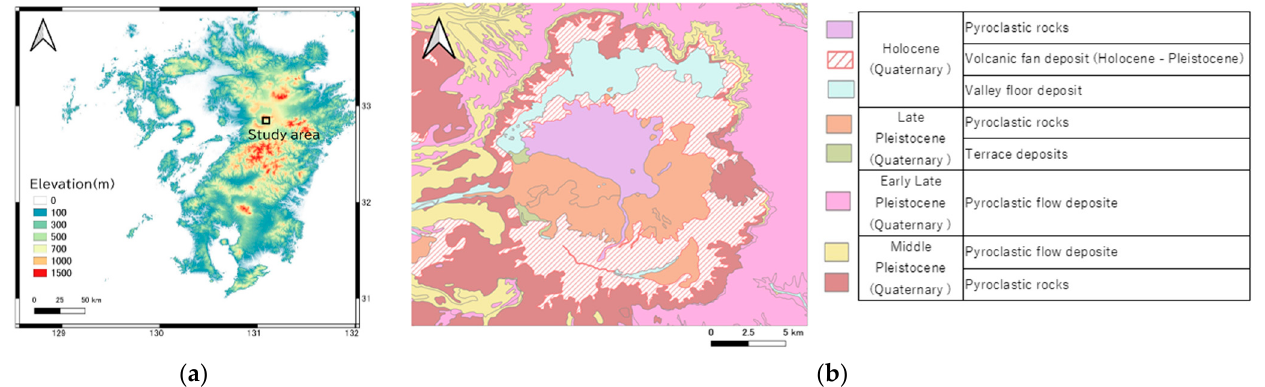
Figure 1. Study area ( a ) Elevation and the location of the study area ( b ) The lithology of the study area.